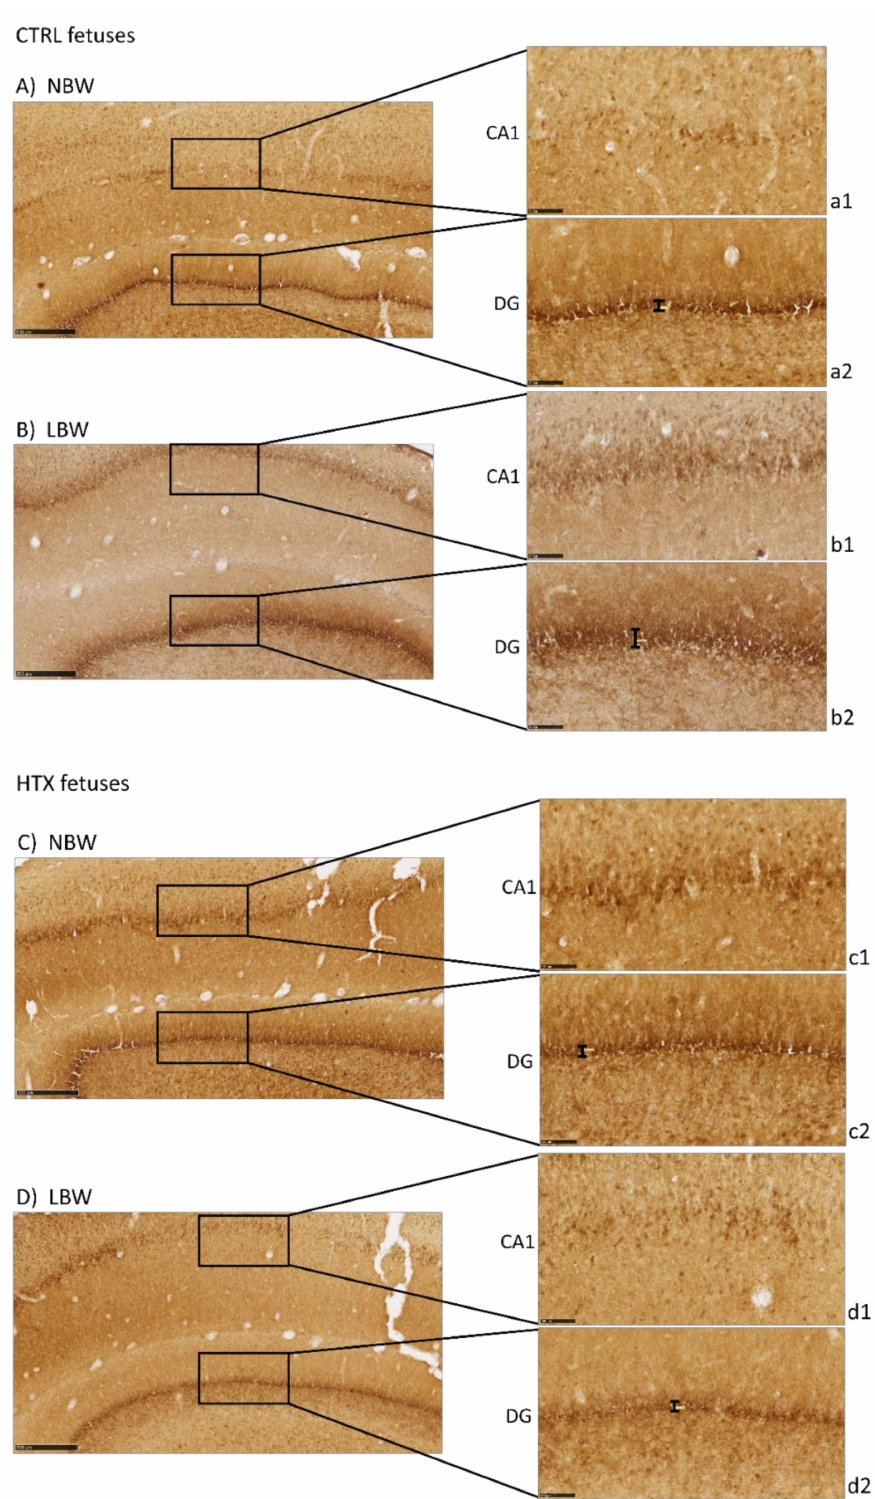
Figure 2. Effect of IUGR on DCX immunostaining on the hippocampus of fetuses whose mothers were not HTX-supplemented ( A , B ) or were HTX-supplemented ( C , D ). Representative images show the immature neurons immunostained with the DCX antibody. Panels are magnifications of the CA1 ( a1 – d1 ) and DG ( a2 – d2 ) areas shown using black boxes. Scale bars: 500 µ m ( A – D ), and 100 µ m ( a1 – d1 , a2 – d2 ). The thickness of the DG area is indicated by a black